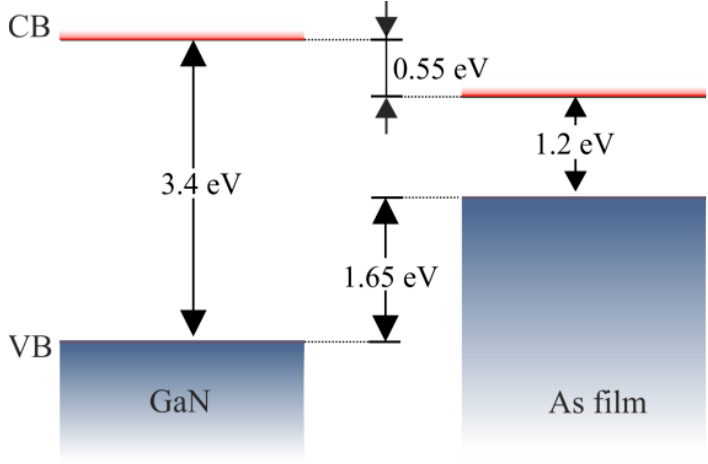
Figure 31. Band diagrams demonstrating valence and conduction band offsets for an As-film-covered GaN(0001) surface.